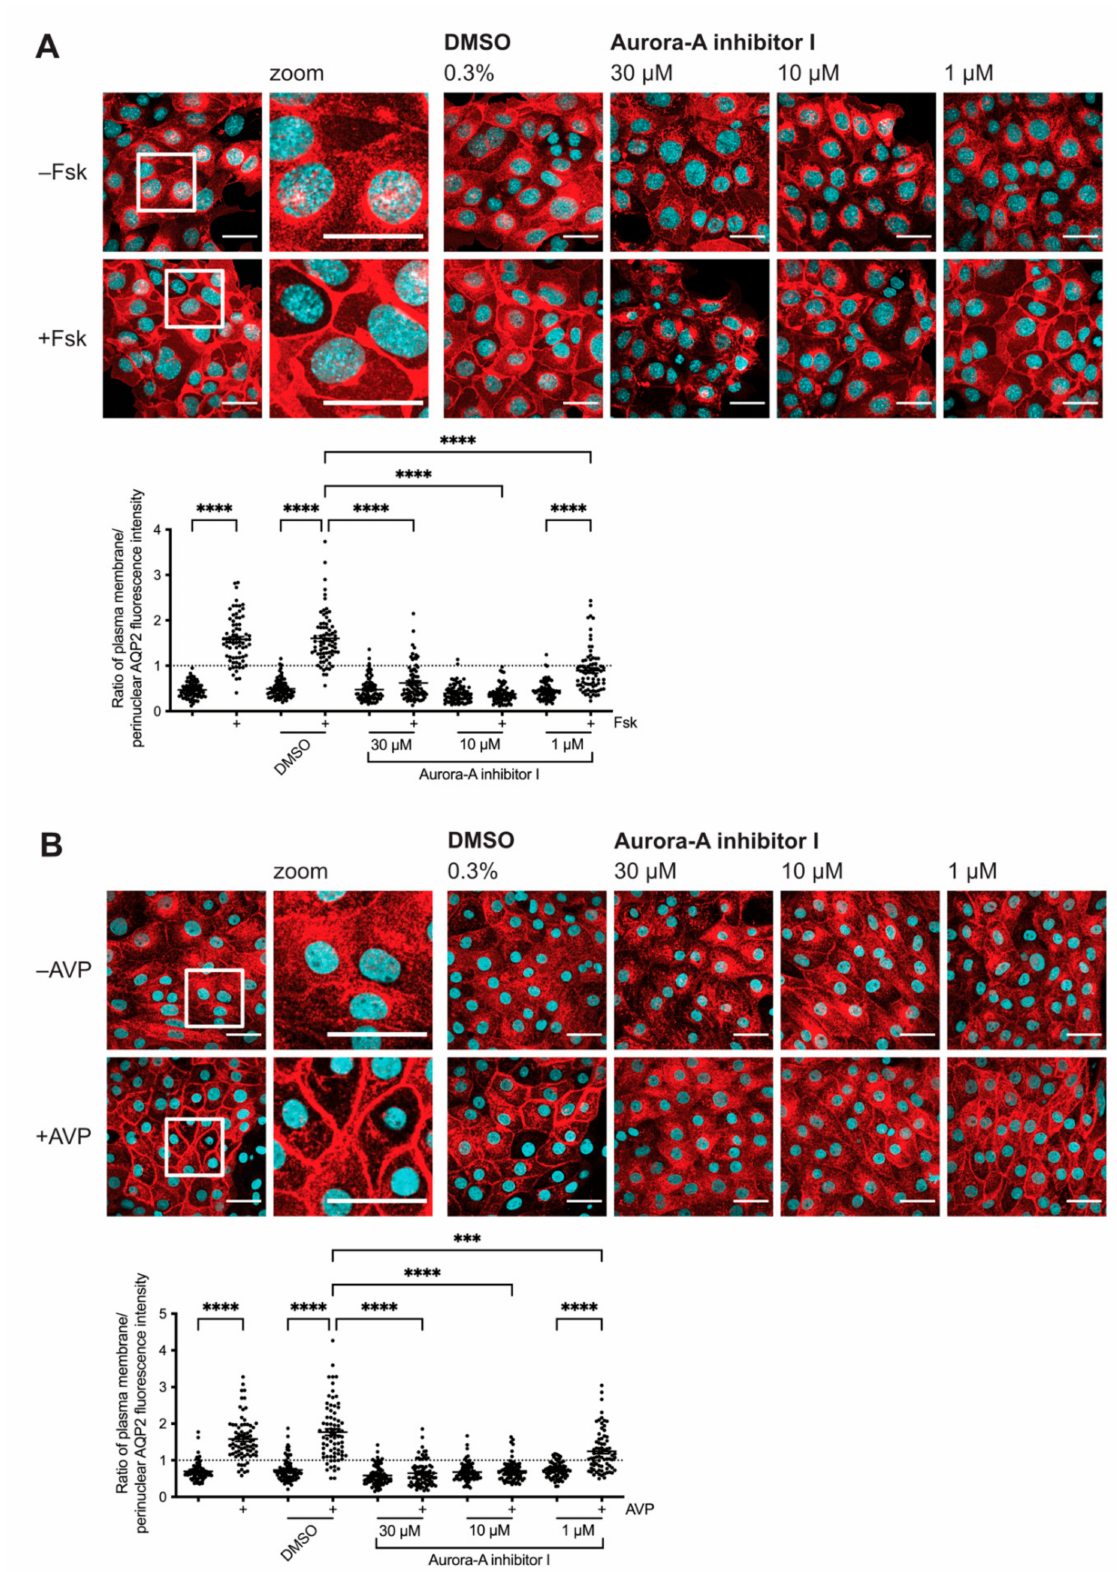
Figure 1. Aurora-A inhibitor I inhibits the cyclic adenosine monophosphate (cAMP)-induced aquaporin-2 (AQP2) redistribution to the plasma membrane of ( A ) immortalized mouse medullary collecting duct (MCD4) and ( B ) primary rat inner medullary collecting duct (IMCD) cells. The